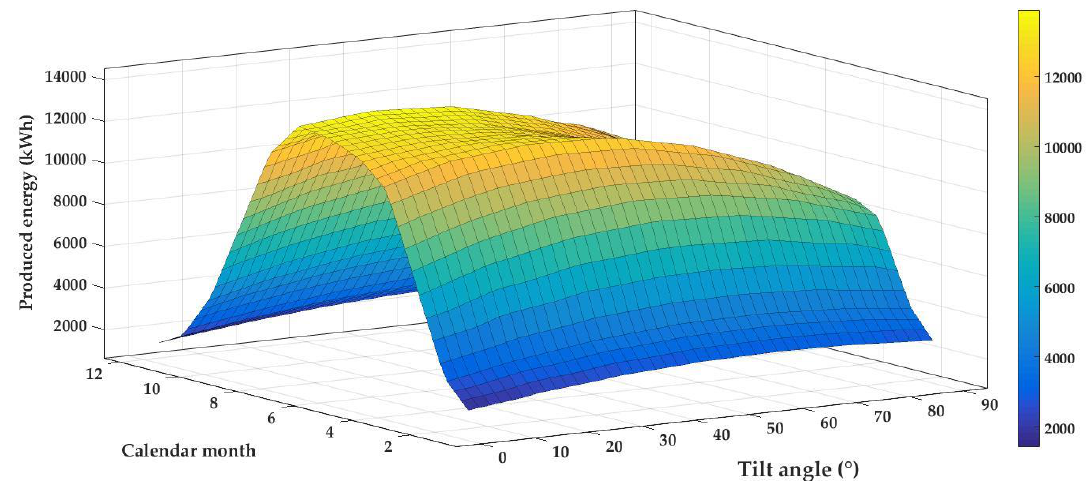
Figure 9. Three-dimensional dependence before polynomial approximation—the influence of tilt angle on the electric energy production of the PV system.